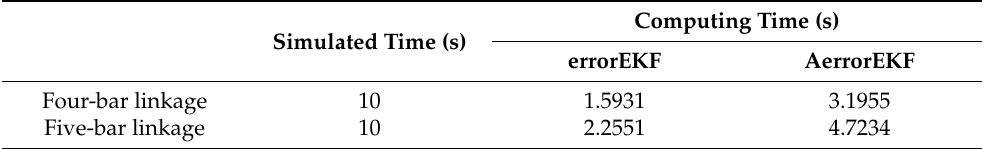
Table 5. Computational cost analysis of the AerrorEKF-FE. The simulations tested correspond to the use of position